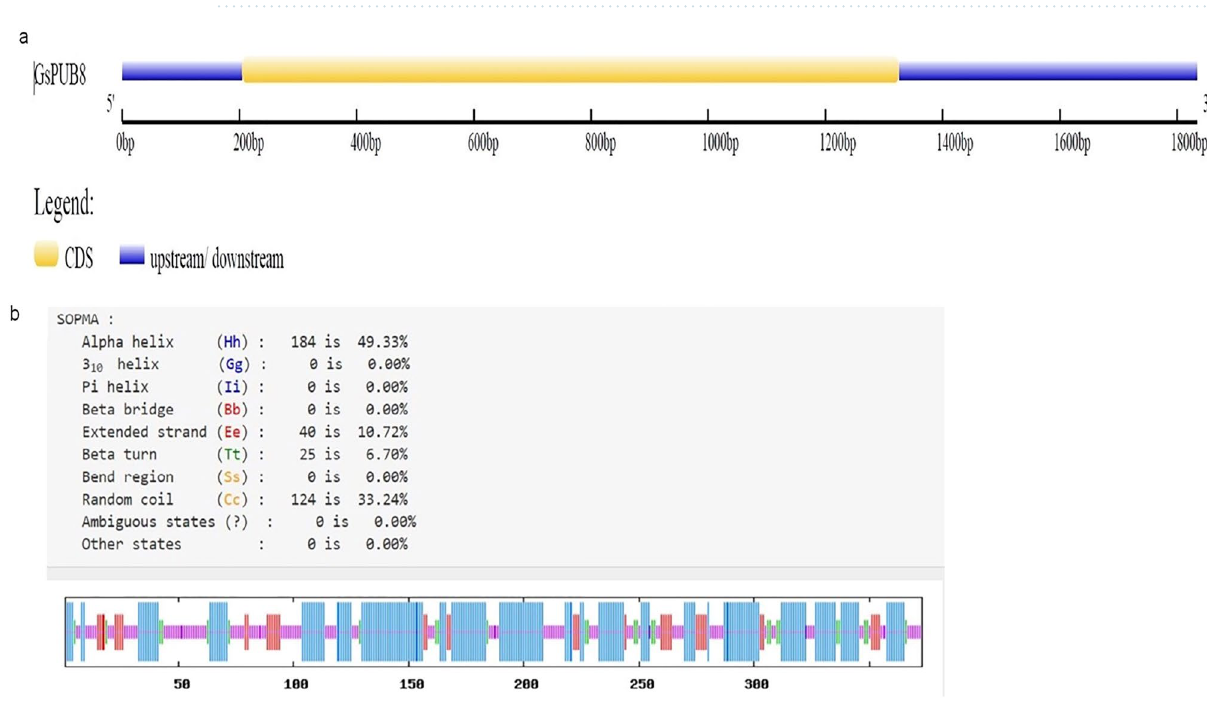
Figure 2. The gene structure analysis of GsPUB8 protein. ( a ) Identification of exon/intron organization. ( b ) The diagrammatic representation of GsPUB8 secondary